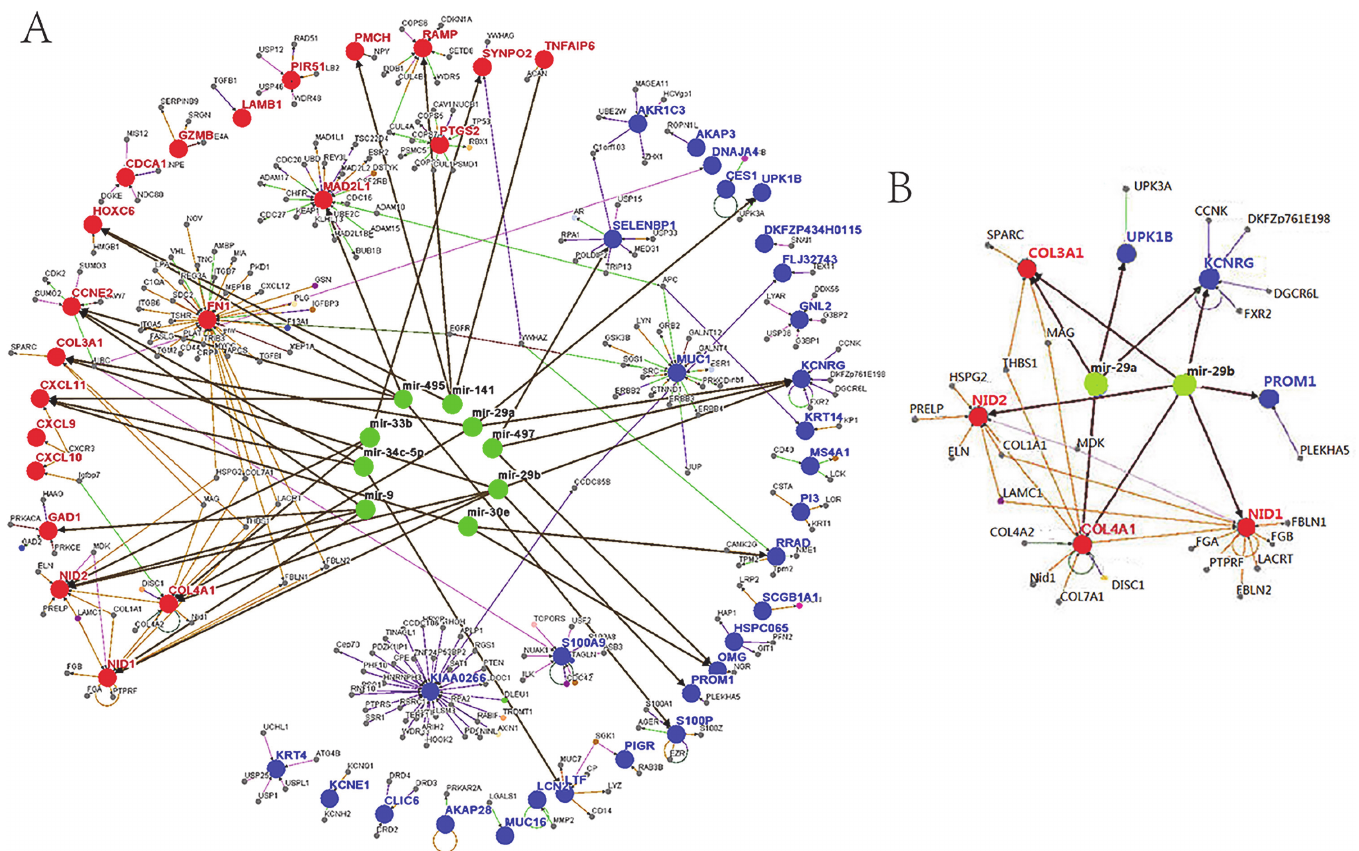
Fig 1. Integrated microRNA-gene network. (A) The miRNA-gene network shows the relationships between 9 miRNAs and 51 dysregulated genes. Only genes reported in BioGrid are shown in this network. Interaction among genes and regulation of miRNAs are indicated by arrows. Red nodes represent up- regulated genes in NPC, and blue nodes represent down-regulated genes. miRNAs with more than 2 targets are shown in the figure. (B) The particular network for miR-29a/b and their targets stems from Fig.